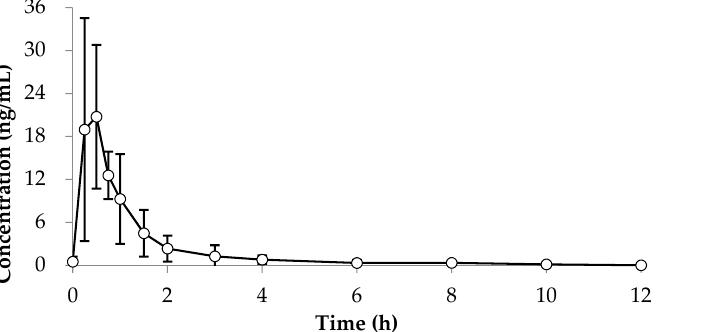
Table 1. Accuracy and precision for the analysis of p -Coumaric acid in human plasma.